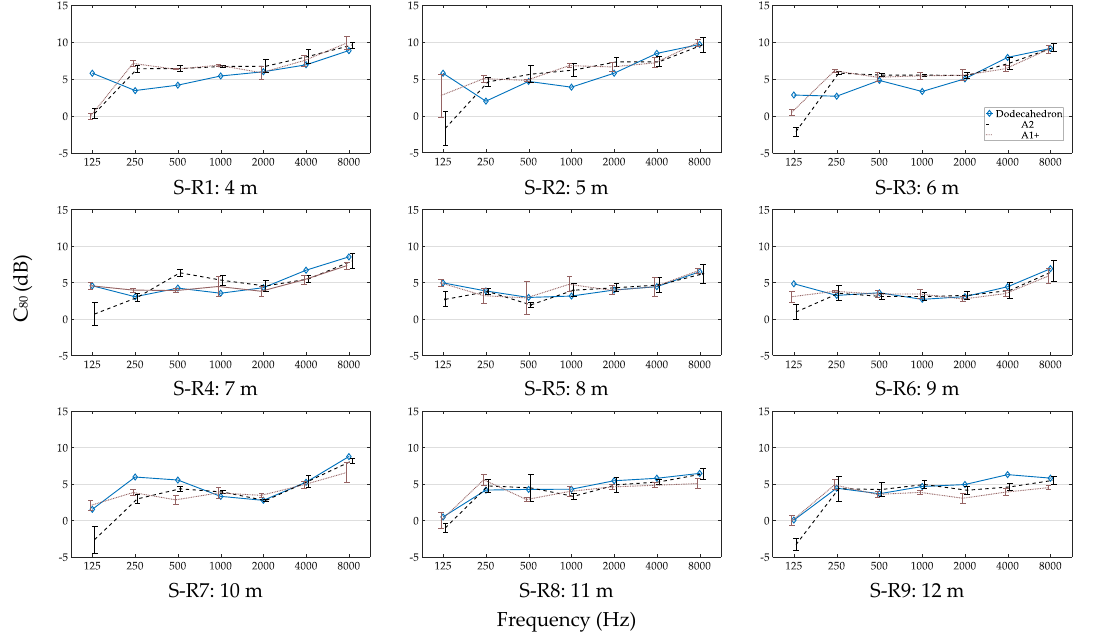
Figure 7. C 80 measurements at different source – receiver (S – R) distances. Error bars represent measured standard deviation.